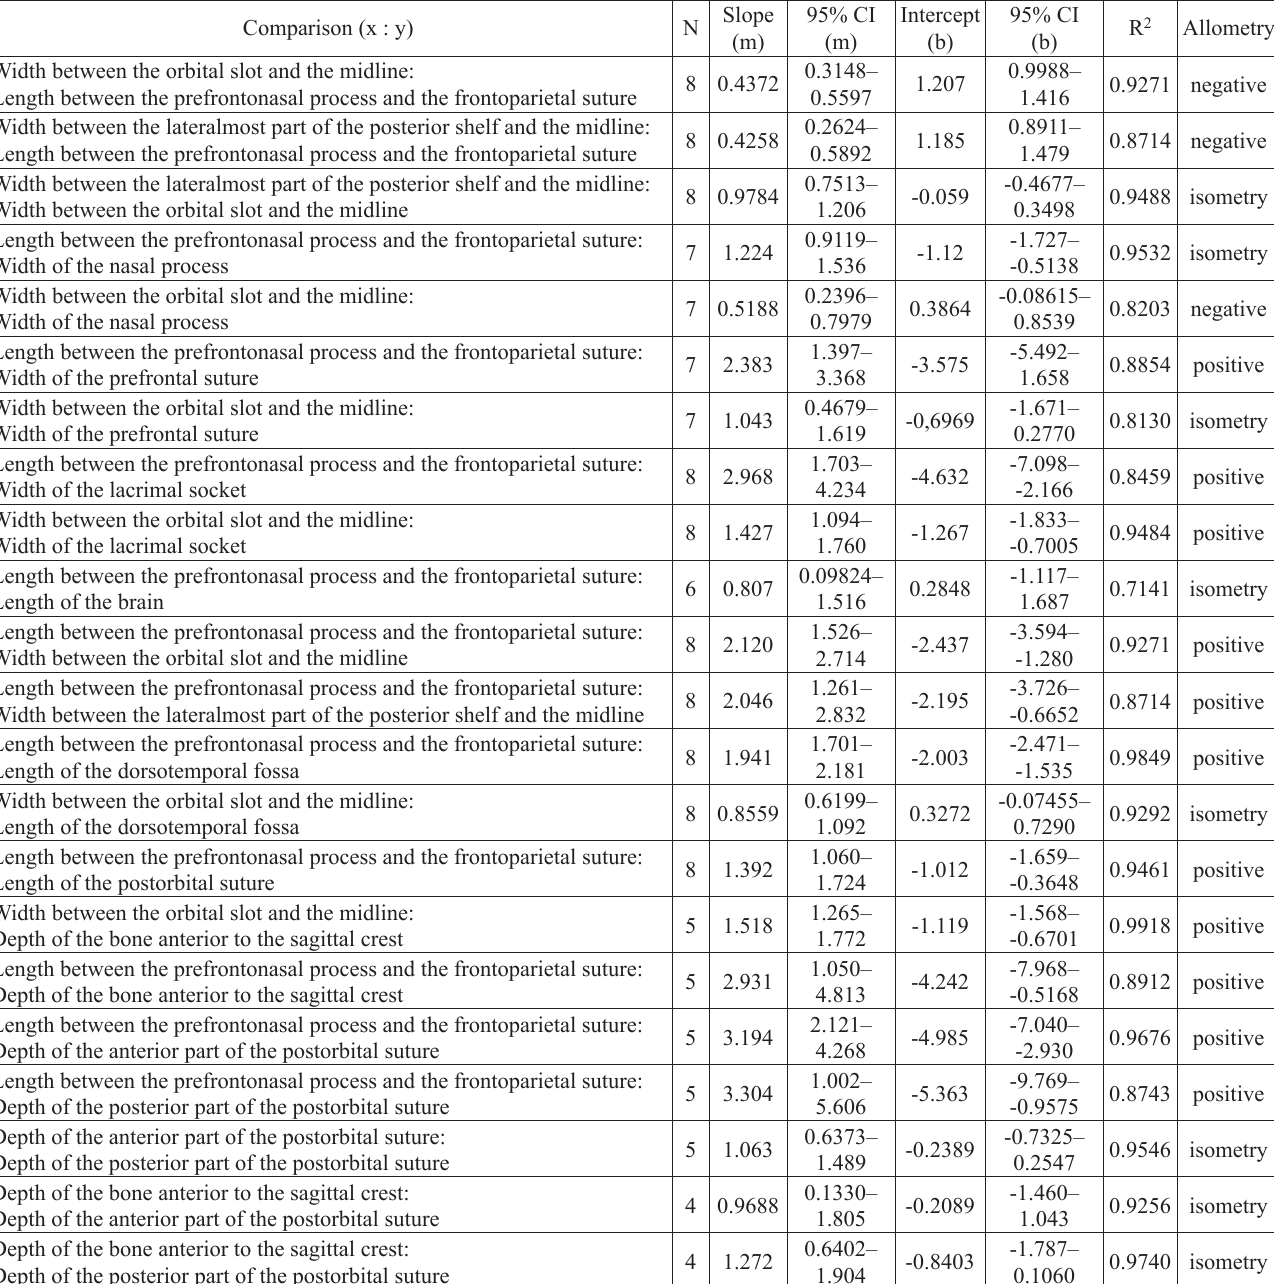
Table 2. Allometric regressions of Tarbosaurus bataar frontal ontogeny. Regression formulas expressed as log (y) = m  log (x) + b. N, number of